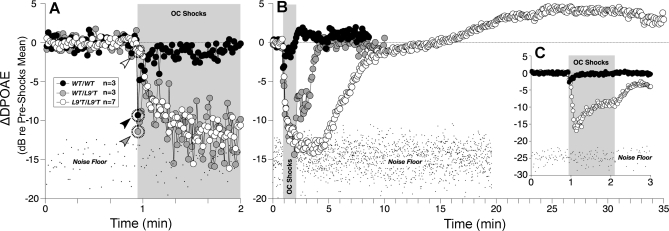
OC-Mediated Suppression of Cochlear DPOAEs Is Slowed, Enhanced and Prolonged in Mutant Mice(A) and (B): DPOAE amplitudes measured before, during, and after a 70-s shock train to the OC bundle (grey boxes) are shown on two different time scales to emphasize the onset effects (A) and the offset effects (B) of OC activation. DPOAE amplitudes from each experiment are normalized to the average preshock value and then averaged across ears within a genotype (group sizes are shown in the key in (A). Arrowheads in (A) indicate the first point after shock-train onset for each genotype: data acquisition times are approximately 1s/point. For (A) and (B), the f2 primary was at 22.6 kHz, and primary levels were adjusted to produce a DPOAE approximately 15 dB above the noise floor: suppression is so strong in mutant ears that the DPOAEs are driven into the noise. WT, wild type.(C) To reveal full suppression magnitude, we raised primary levels until preshock DPOAEs were 25 dB above the noise floor: peak suppression in Chrna9L9′T/L9′T reached approximately 17 dB, whereas for Chrna9wt/wt, effects were less than approximately 5 dB at these higher stimulus levels.